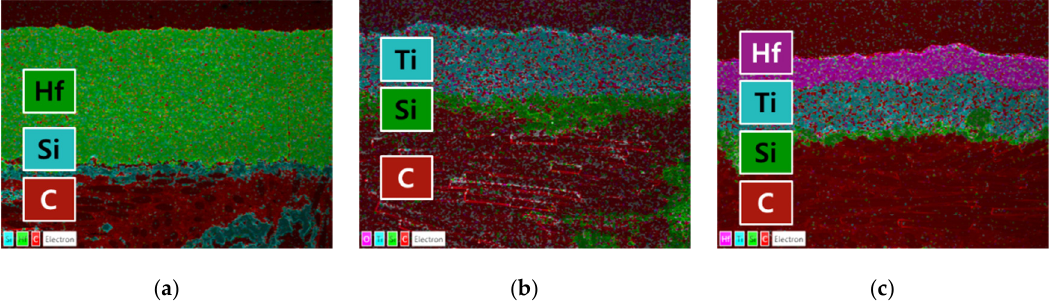
Figure 5. EDS mappings of ( a ) HfC coating, ( b ) TiC coating, and ( c ) HfC/TiC coatings.